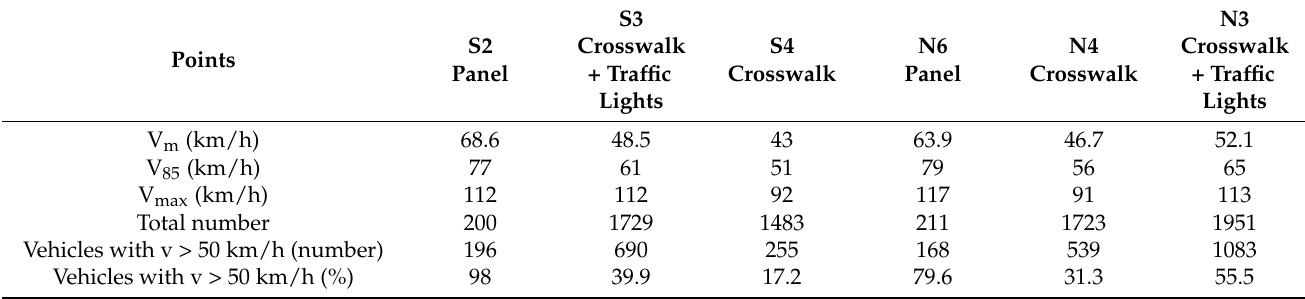
Table 5. Values of selected variables at control points in Arrespalditza/Respaldiza (Spain).